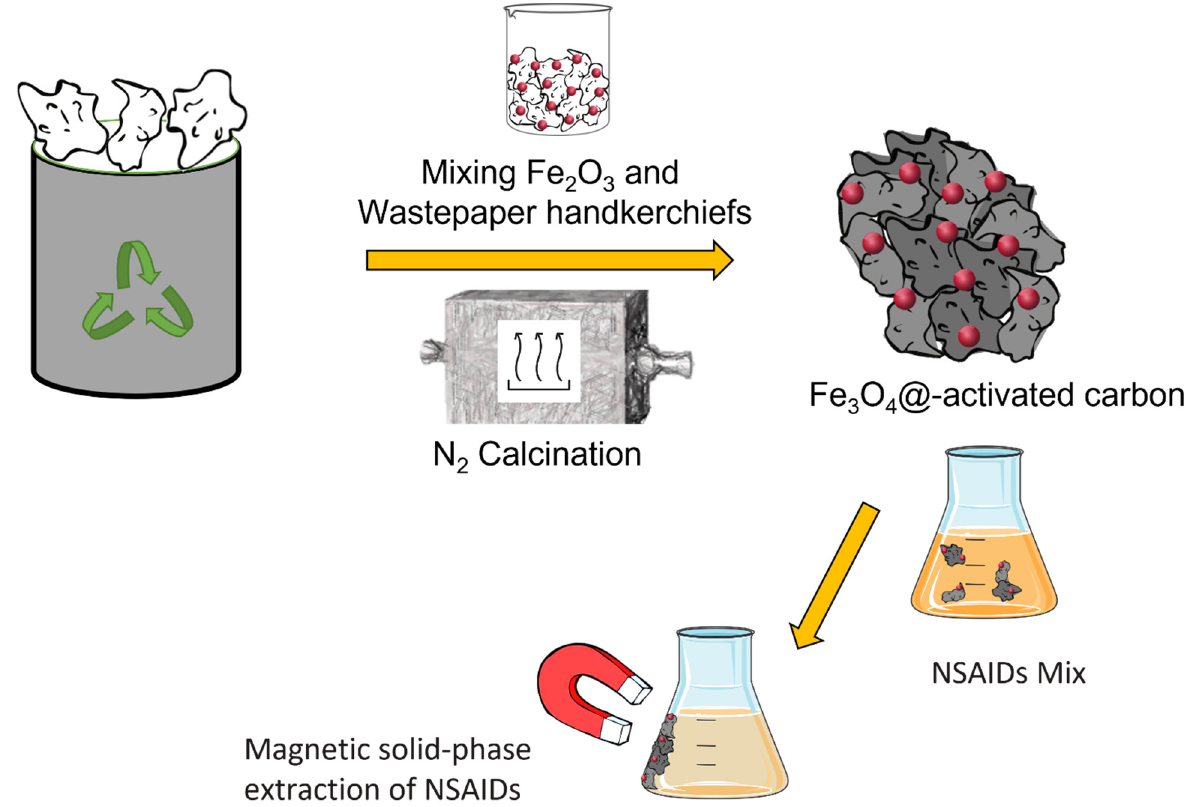
Figure 1. Graphical representation of the main steps of sample preparation and MSPE of NSAIDs performed in this study.